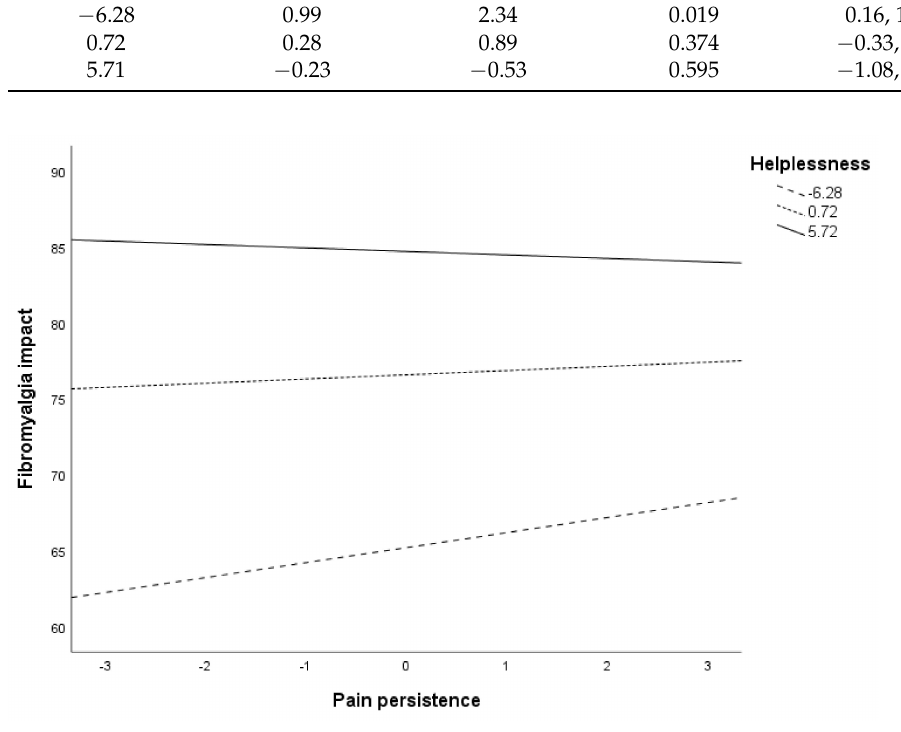
Figure 2. Conditional effects of pain persistence on fibromyalgia impact at different values of help- lessness.